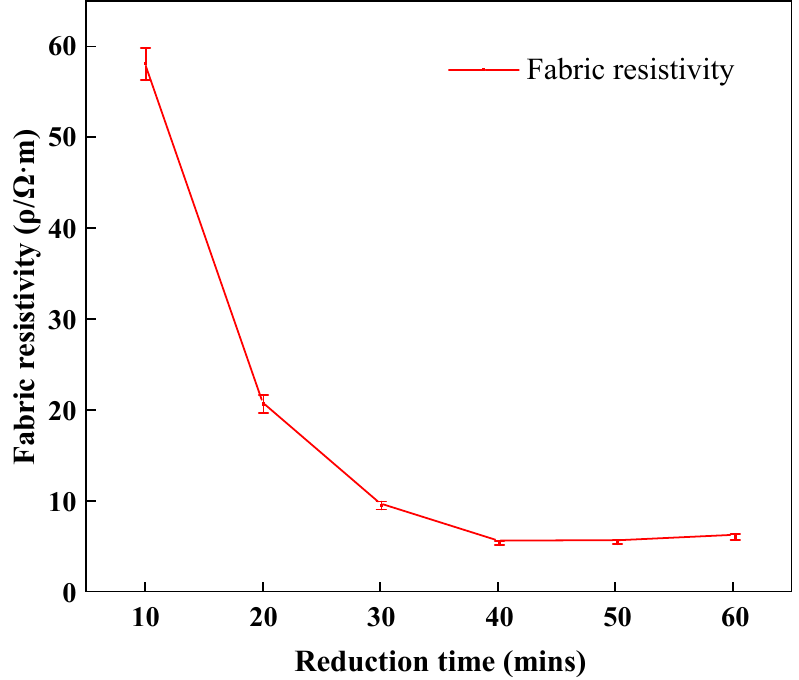
Figure 5. Fabric resistivity of different samples with different reduction times.